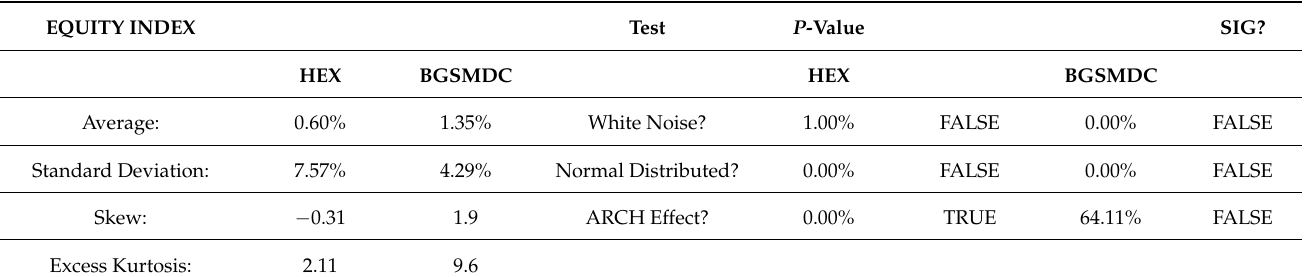
Table 2. Summary statistics. Source: